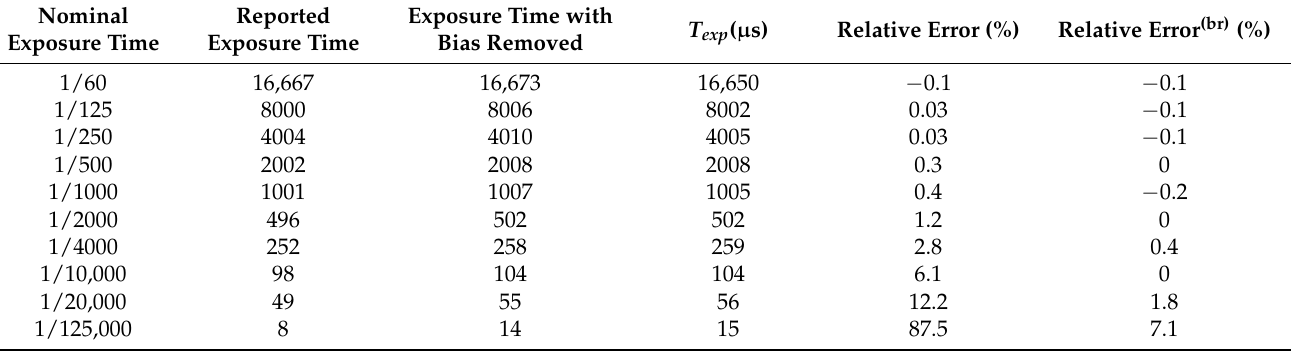
Table 7. Measurement results of C3, using the equivalent sampling method.